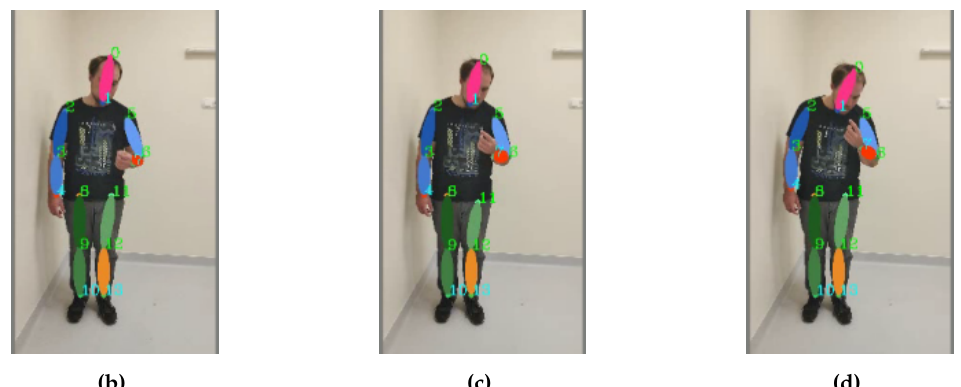
Figure 11. Exercise “Finger–Nose” is performed with compression of the torso: the motion sequence ( a – d ) starts on the left and ends on the right.